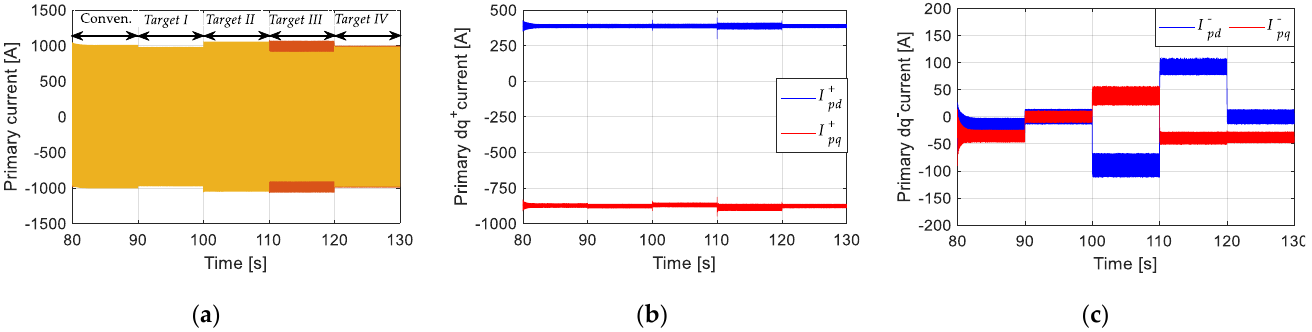
Figure 13. Simulated results with 10% primary voltage unbalance: 90 – 100 s: Target I ; 100 – 110 s: Target II ; 110 – 120 s: Target III ; 120 – 130 s: Target IV ; ( a ) primary current; ( b ) positive components; ( c ) negative components.